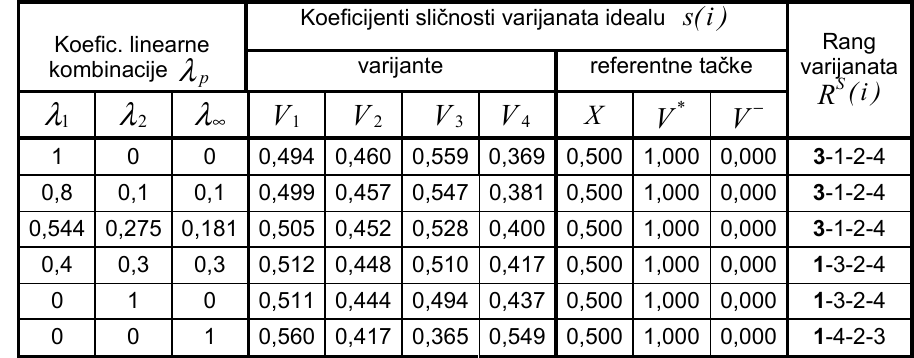
Таблица 7 – Вектор сходства вариантов с идеальным при разных значениях коэффициента λ p Table 7 – Similarity to ideal vector of alternatives for different values of the coefficients λ p Koeficijenti sli č nosti varijanata idealu )i(s Koefic. linearne kombinacije λ p